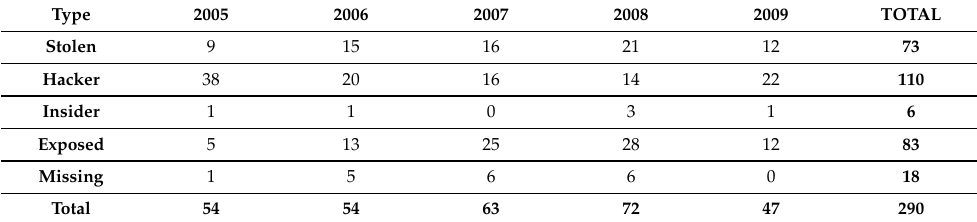
Table 7. Table from Ncube and Garrison [2] (p. 33), of the number of incidents per